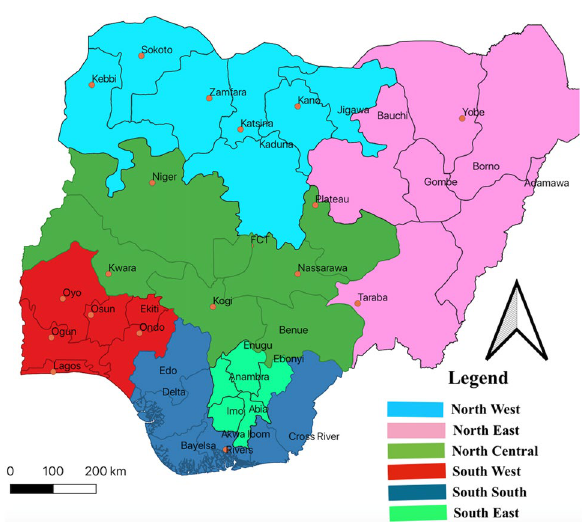
Figure 2. Nigeria geopolitical